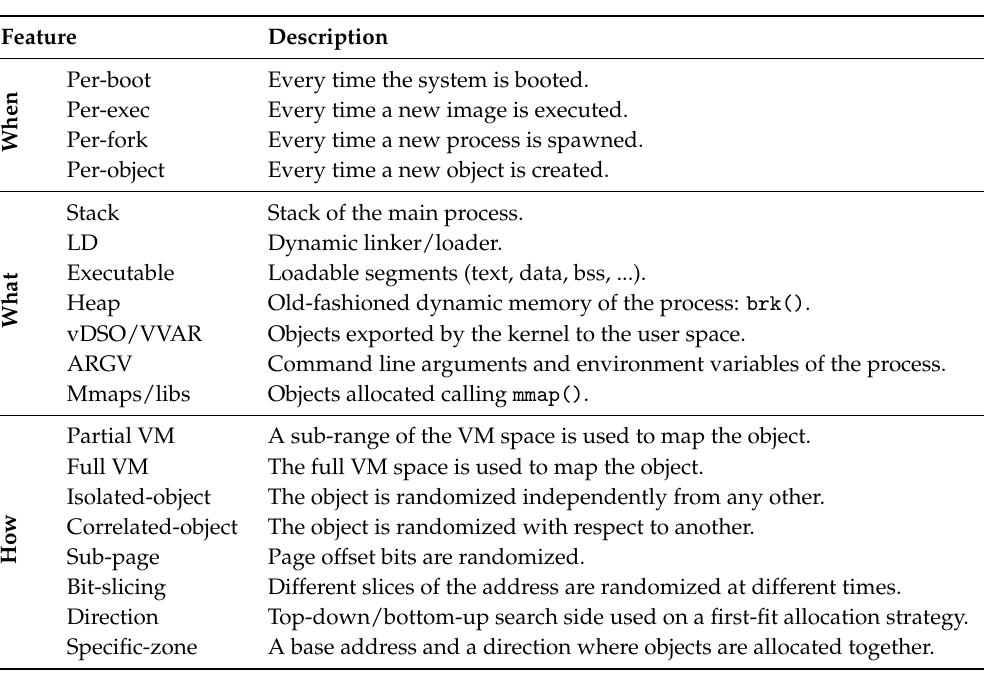
Table 1. Summary of randomization forms and